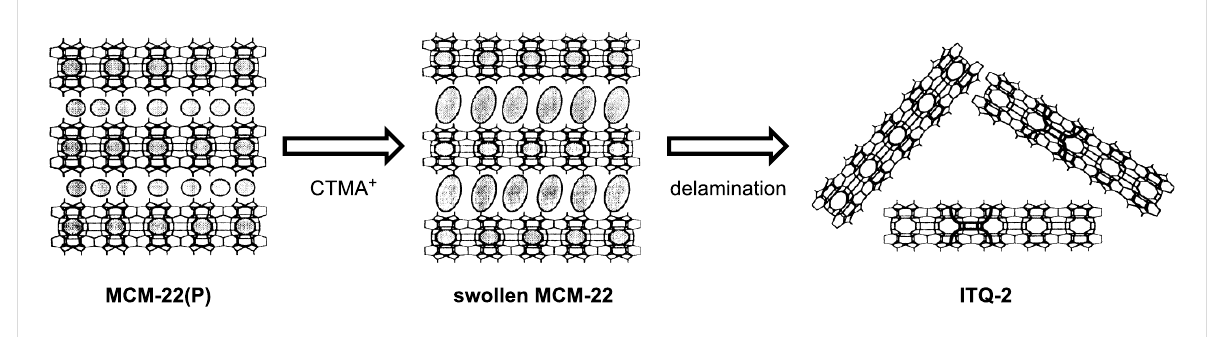
Figure 4: Schematic representation of the delamination process (CTMA + = cetyltrimethylammonium ion). Reprinted from [93]. Copyright 2000, with permission from Elsevier.